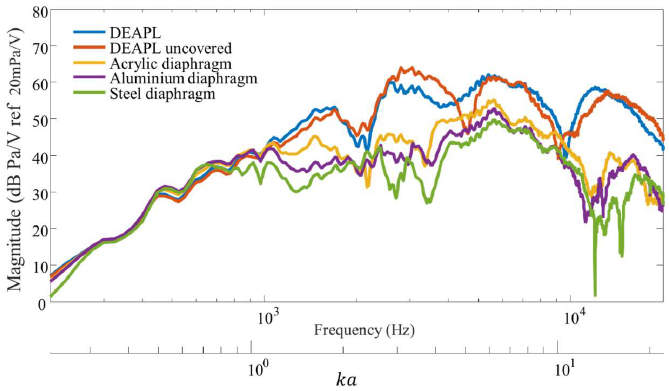
Figure 9. Transfer functions between supplied voltage and on-axis sound pressure measured 50 cm from the DEAP loudspeaker in a semi-anechoic chamber.